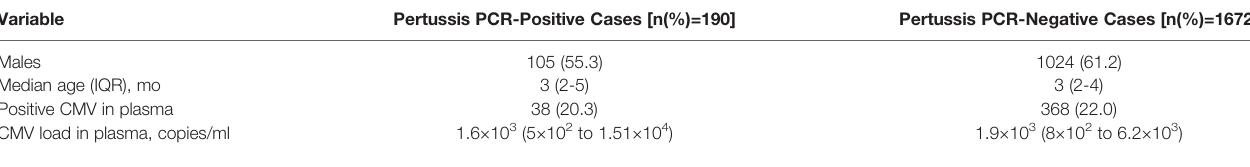
TABLE 1 | Comparison of key descriptive variables between pertussis PCR-positive and negative cases. Variable